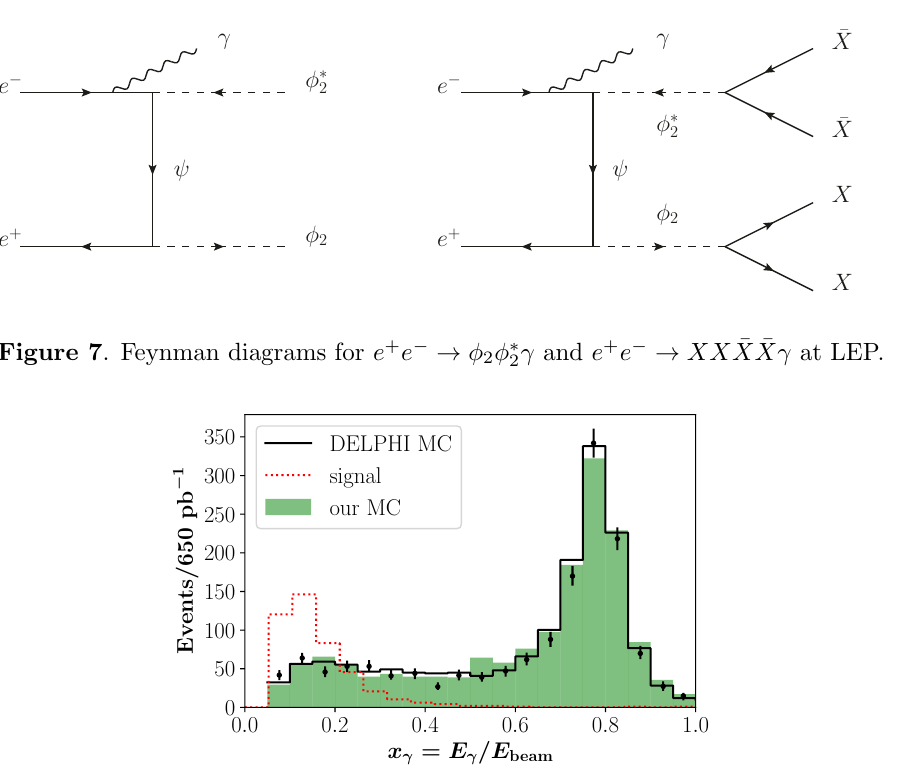
Figure 8 . Distribution of normalized photon energy in single-photon events at DELPHI. The data (black dots with error bars) as well as the DELPHI Monte Carlo (black histogram) and our Whizard simulation (green histogram) are shown. The peak at x (cid:13) 0 : 8 corresponds to the process (cid:24) e + e (cid:0) (cid:13)Z (cid:13)(cid:23) (cid:22) (cid:23) with an on-shell Z . The red dotted histogram corresponds to the signal photon ! ! spectrum for the process e + e (cid:0) XX (cid:22) X (cid:22) X(cid:13) , for g = 3 and M = 20 !